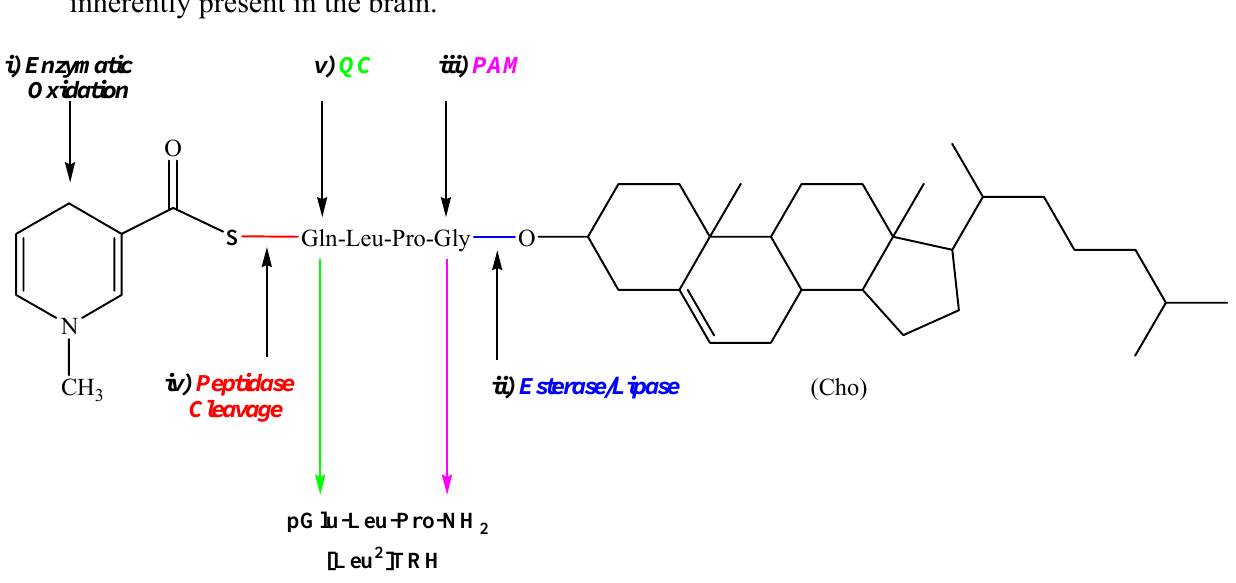
Figure 2. Schematic illustration of the prodrug concept developed for the brain delivery of [Leu 2 ]TRH utilizing Gln-Leu-Pro-Gly progenitor sequence and enzymes ( i to iv ) inherently present in the